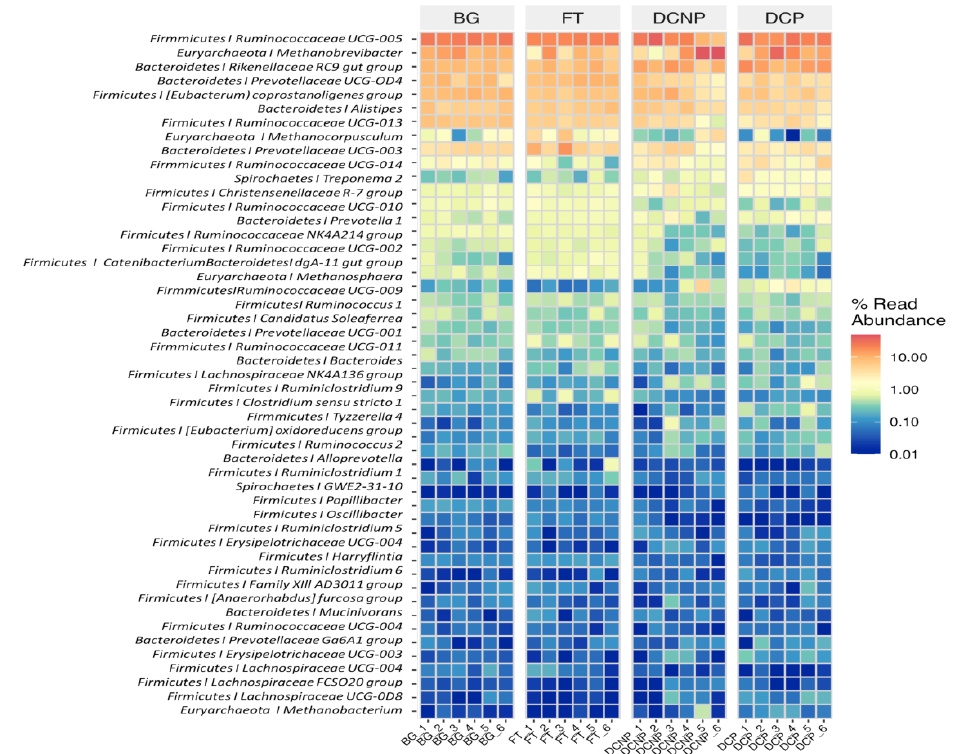
Figure 3. Relative abundance of fecal microbiota at the phylum level in the four groups.